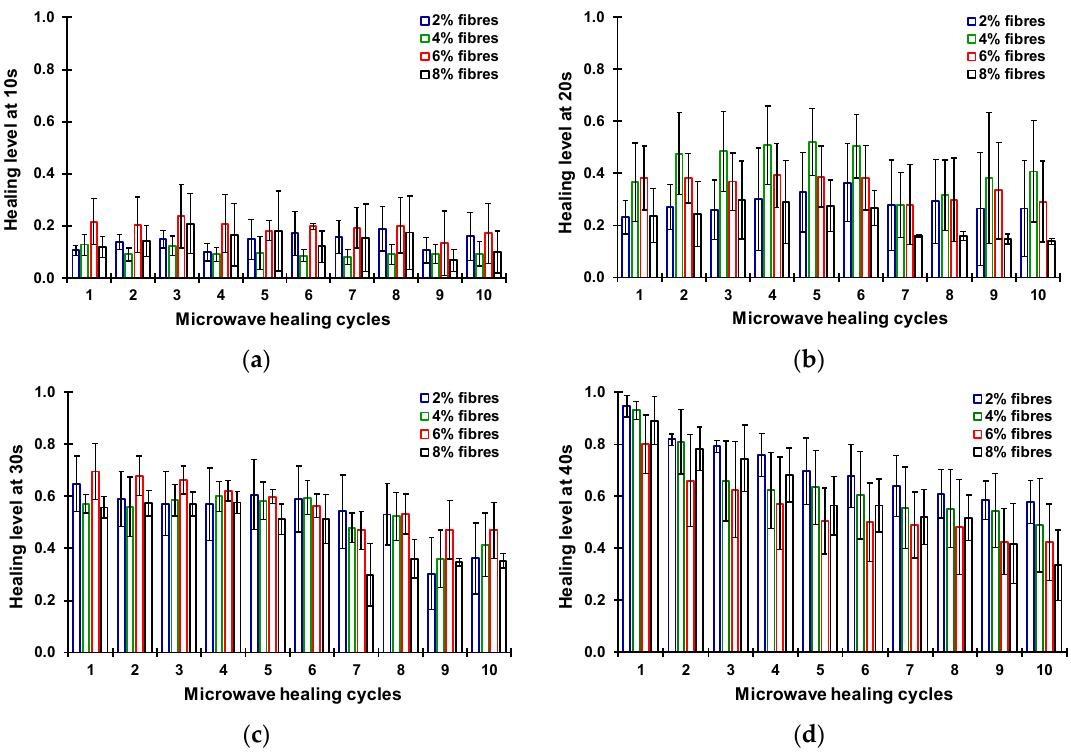
Figure 6. Healing levels of asphalt mixtures with different content of fibres, depending on the number of healing cycles, heated in a microwave at 4 different times: ( a ) 10 s; ( b ) 20 s; ( c ) 30 s and ( d ) 40 s.